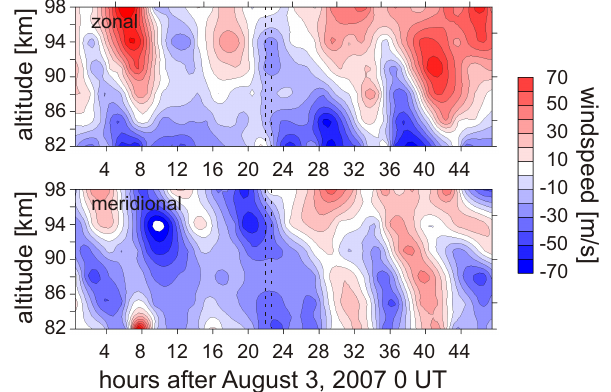
Fig. 15. Temporal evolution of the wind field above ALOMAR on 3/4 August 2007 as measured by the meteor radar. The time of the MASS and the ECOMA sounding rocket launches are marked by vertical